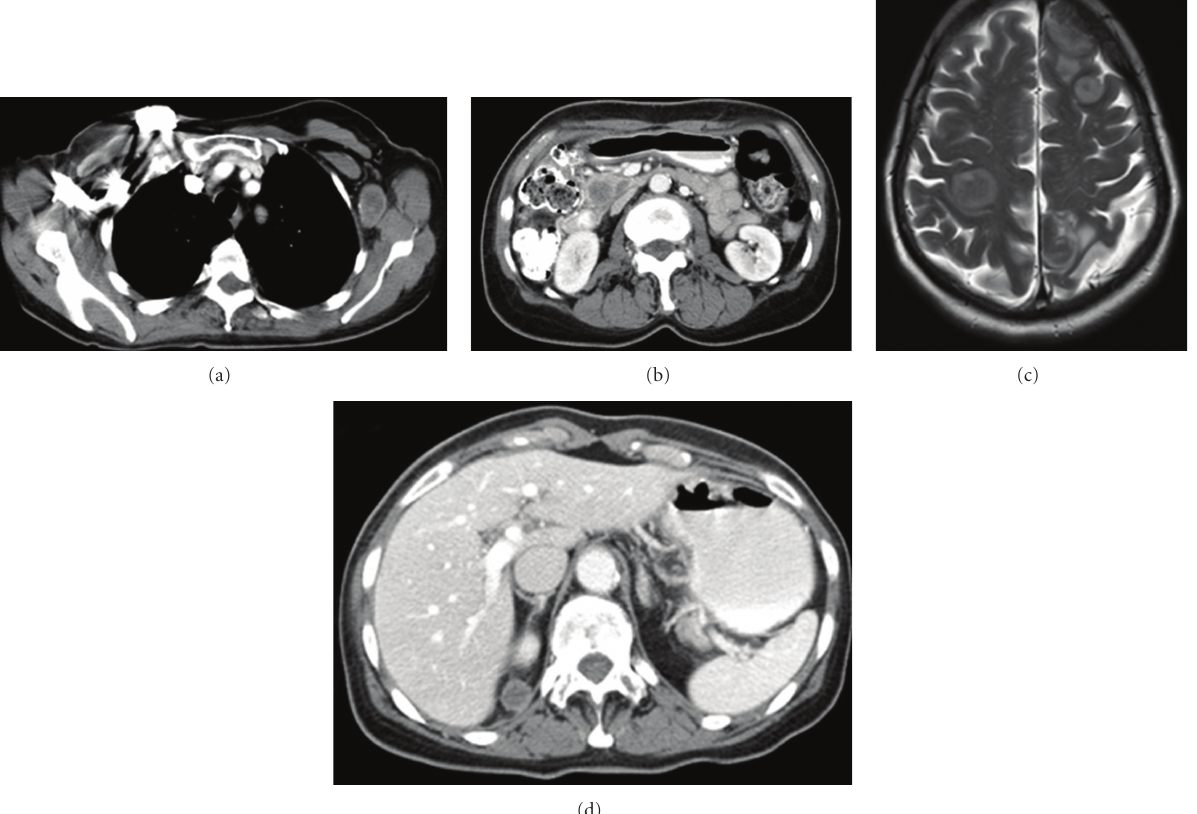
Figure 3: Metastatic disease: (clockwise starting from upper left) left axillary lymph node, pancreatic lesions, multiple brain metastases, and right superior perinephric